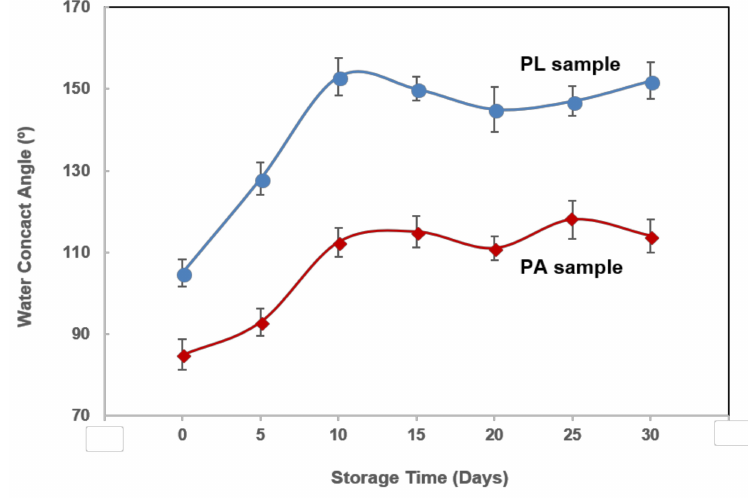
Figure 6. WCA development of PL and PA samples stored in